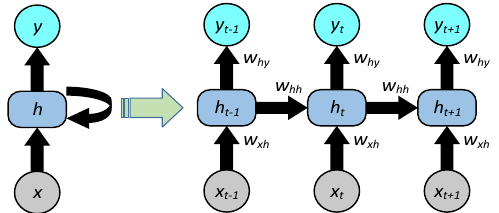
Figure 6. The RNN structure. Figure 5. PV power output for five different weather types. Table 2. The number of days in the training and testing stages.